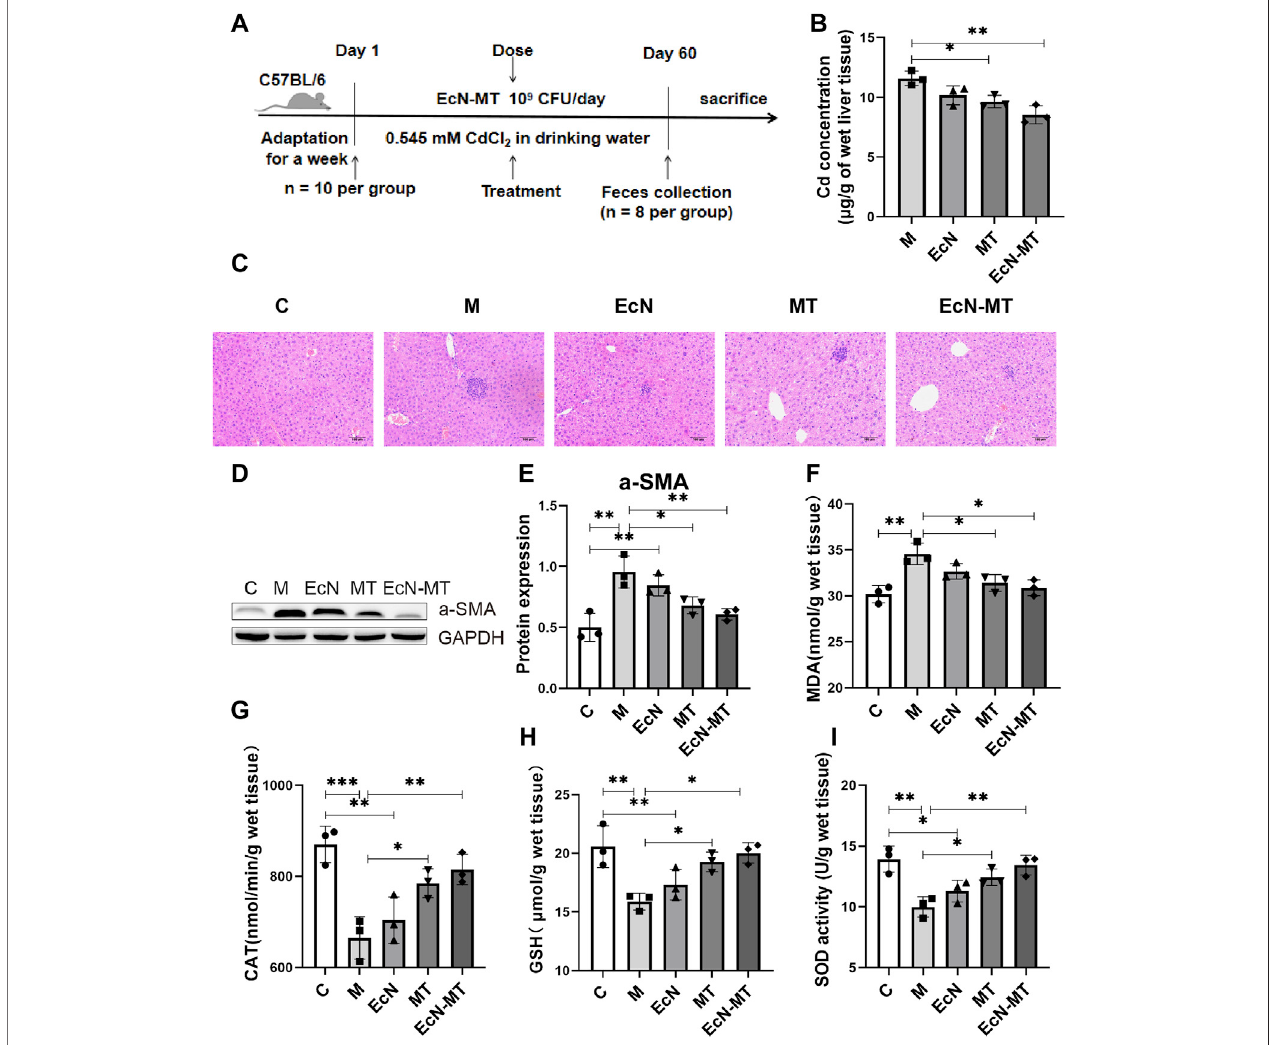
FIGURE2| EcN-MTtreatmentreduceliverinjury, fi brosis,oxidativestressintheliverofmice.Valuesarepresentedasmeans±SD( n =3). (A) TreatmentofEcN-MT in mice with subchronic Cd exposure. (B) Cd concentrations in the liver assayed by ICP-MS. (C) HE staining image of liver tissue (200×). (D) Western bloting analysis of a-SMAexpression inliver tissues. (E) Therelative expressionsofa-SMA werequanti fi ed byImageJ. GAPDHwasused asan internal control. Theactivity of (F) MDA, (G) CAT, (H) GSH, (I) SOD. * p < 0.05, ** p < 0.01, *** p < 0.001.